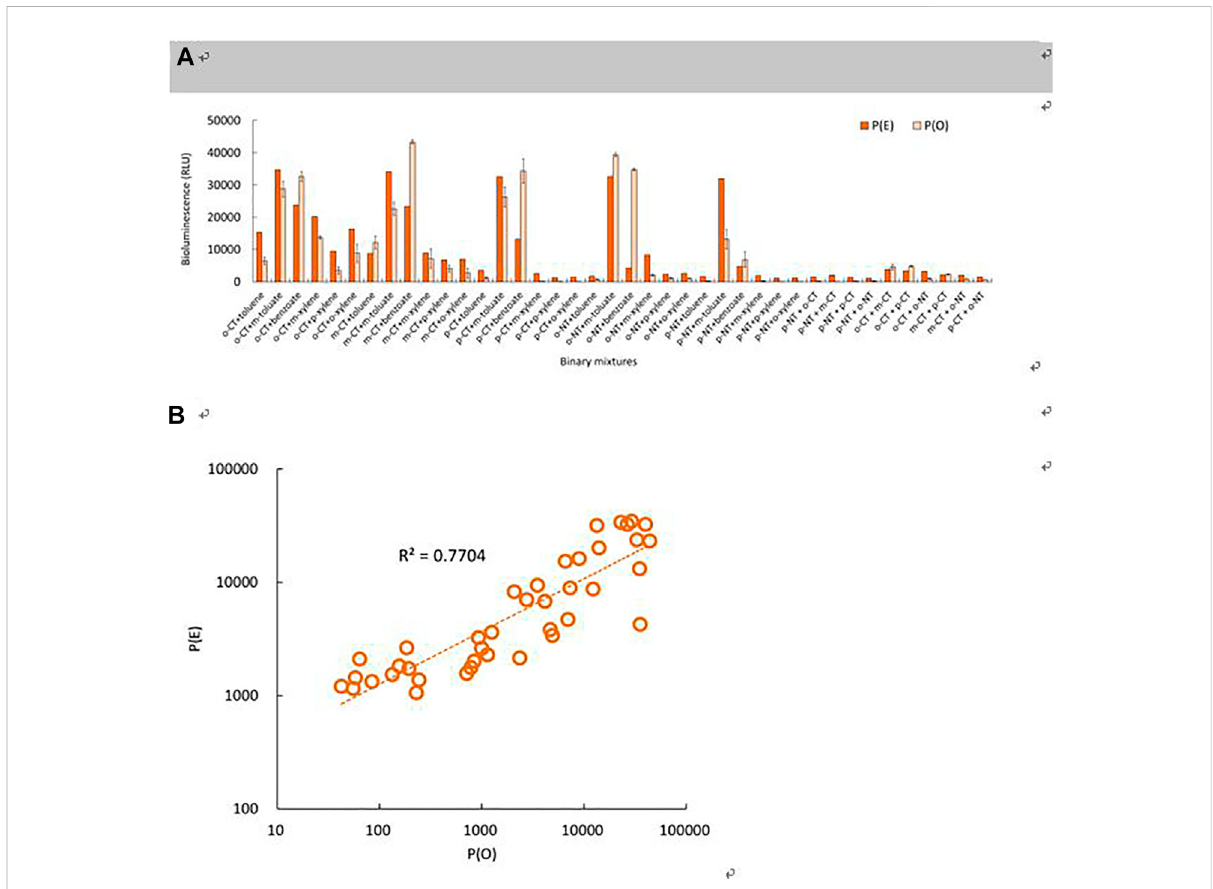
FIGURE 6 Comparisons of the P(E) and P(O) of the binary mixtures of inducers based on the total bioluminescence produced during 2.5 h incubation periods of KG1206: (A) labels show the combinations of the binary mixtures and (B) correlation between P(O) and